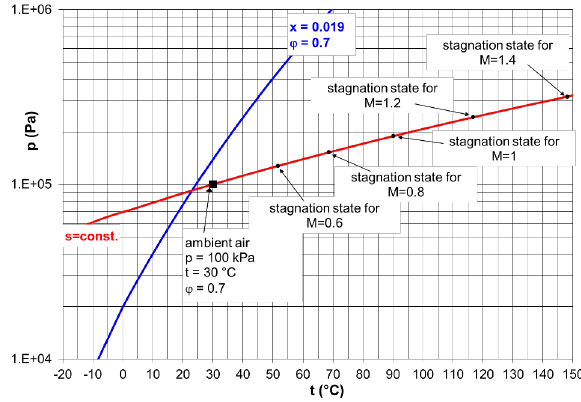
Fig. 5. p − t phase diagram of the moist air with the specific humidity x = 0 . 0019 kg V / kg DA and the isentrope ( s = const . ) crossing the point of the state t a = 30 ◦ C, p a = 0 . 1 MPa and ϕ = 70% with the marked stagnation states for the selected values of the aircraft Mach number .